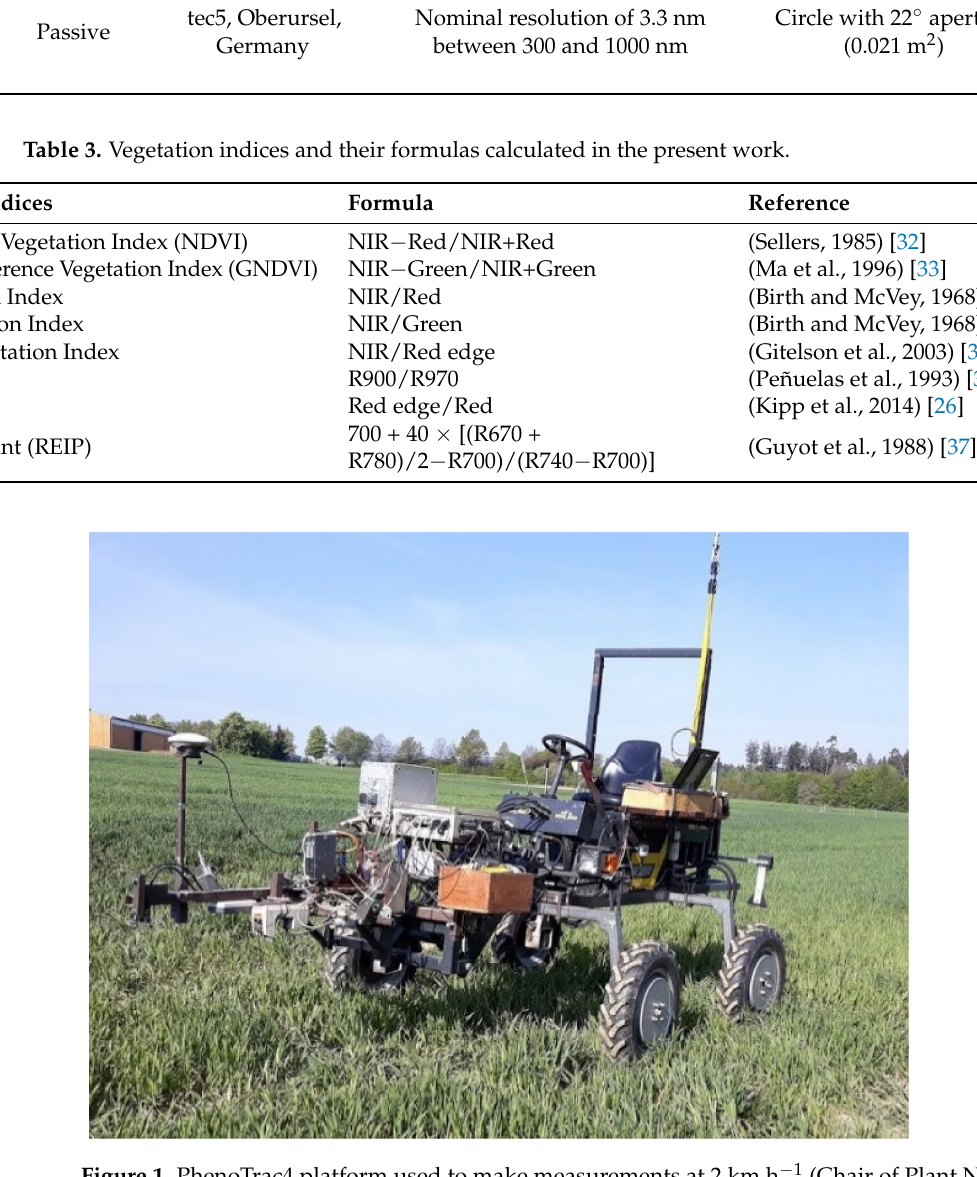
Figure 1. PhenoTrac4 platform used to make measurements at 2 km h − 1 (Chair of Plant Nutrition, Technical University of